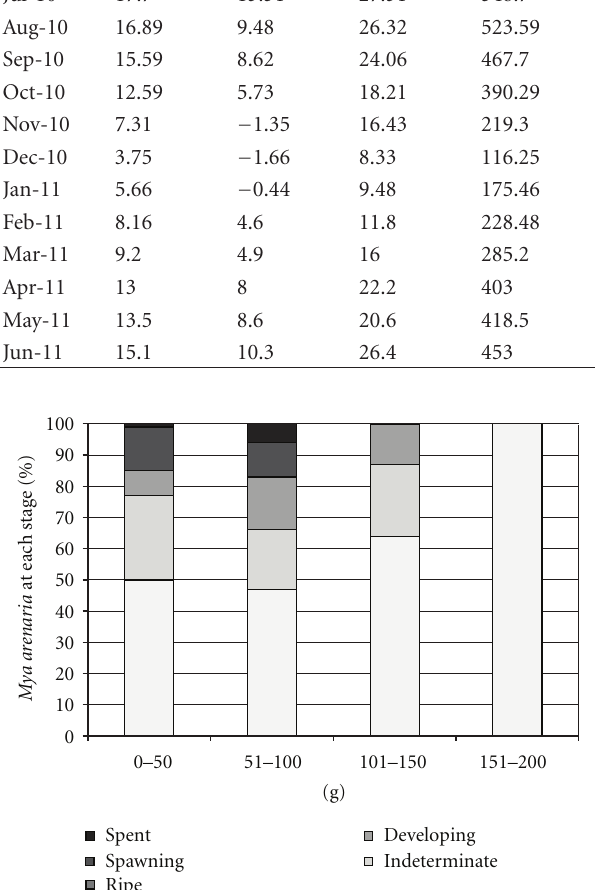
Figure 9: Relationship between male Mya arenaria weight and stage of